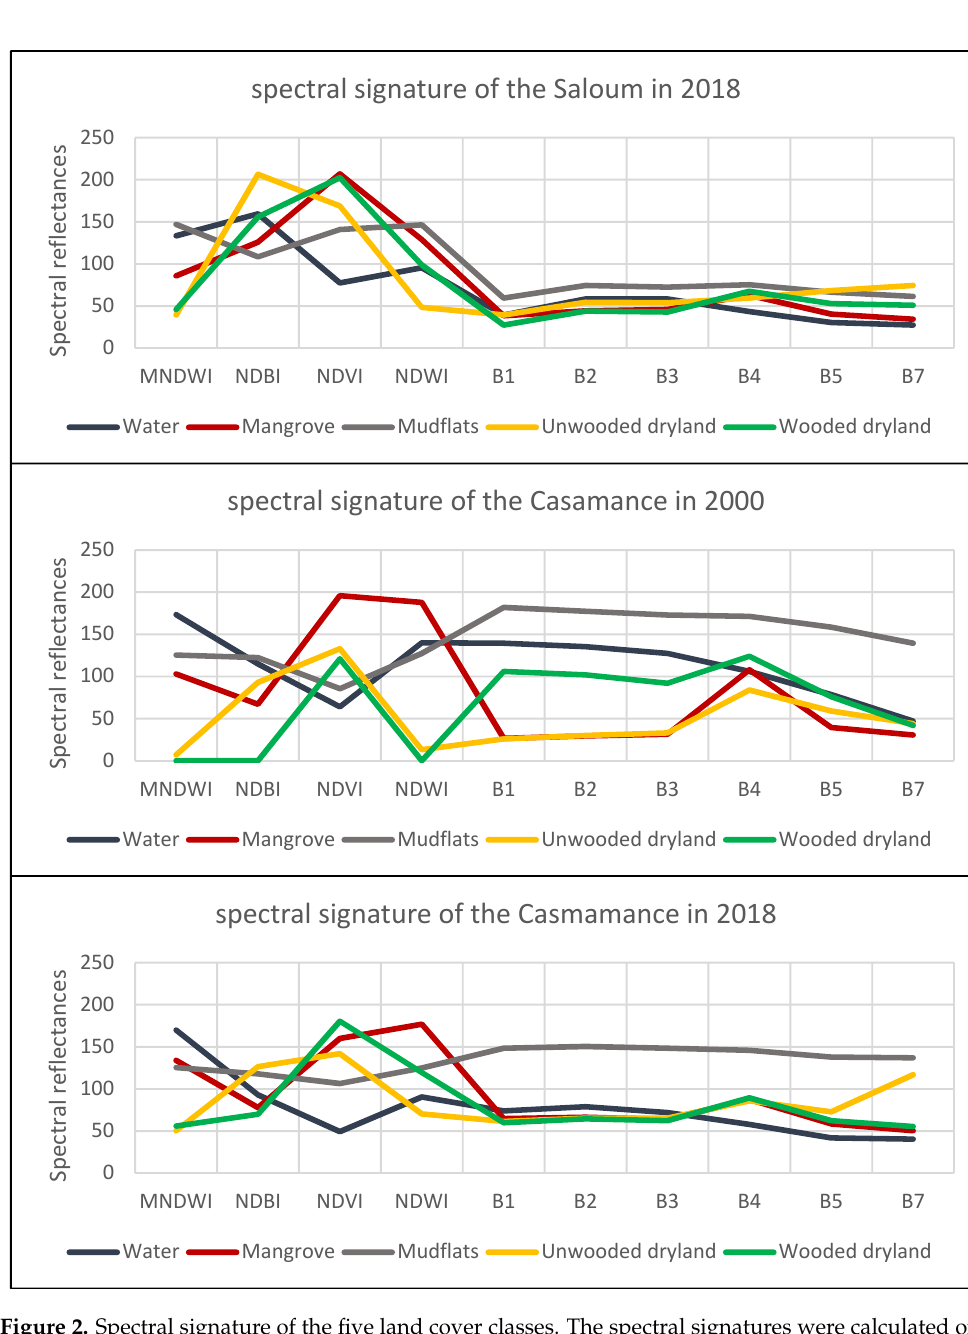
Figure 2. Spectral signature of the five land cover classes. The spectral signatures were calculated on each Landsat scene, on both dates and on each area. The values on the y-axis represent the average reflectance for each class.